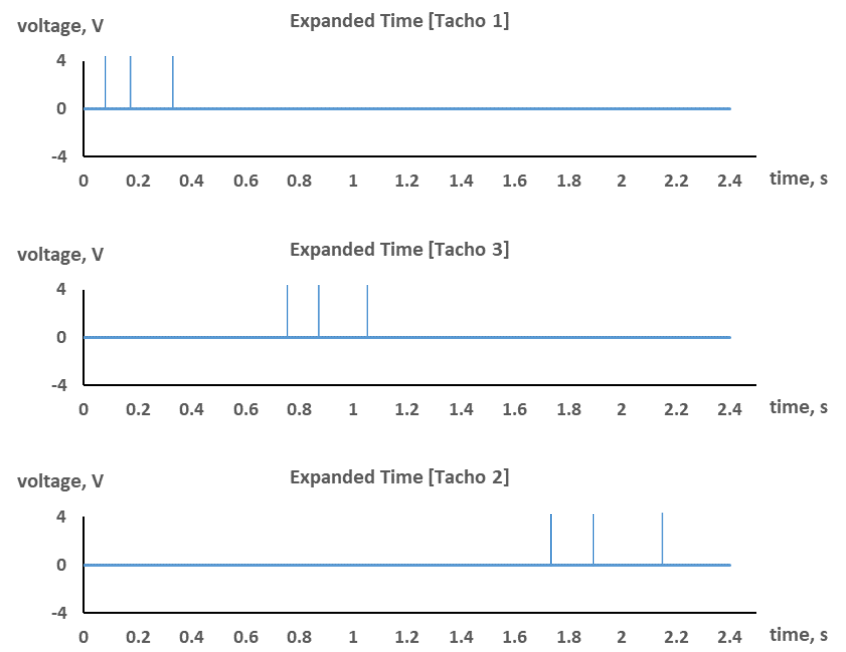
Figure 4. Time needed by the carriage to travel along the belt, as recorded by the Tacho 1, Tacho 2 and Tacho 3 and Tacho 3 probes.